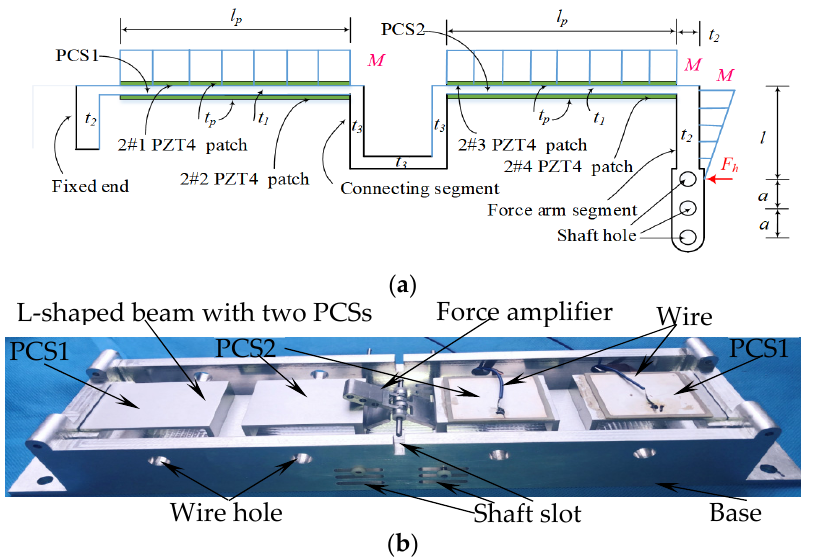
Figure 3. 2# piezoelectric brick made of a pair of LPCBs with two PCSs. ( a ) A section view of an LPCB with two PCSs; ( b ) An experiment specimen of 2# piezoelectric brick.